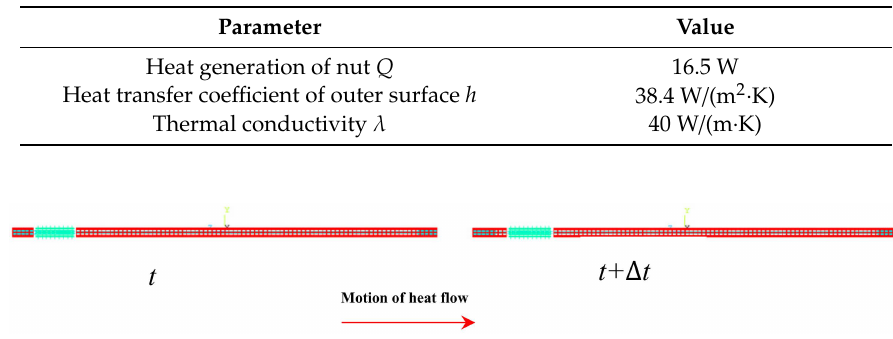
Figure 5. Heat flow motion in the FE method.